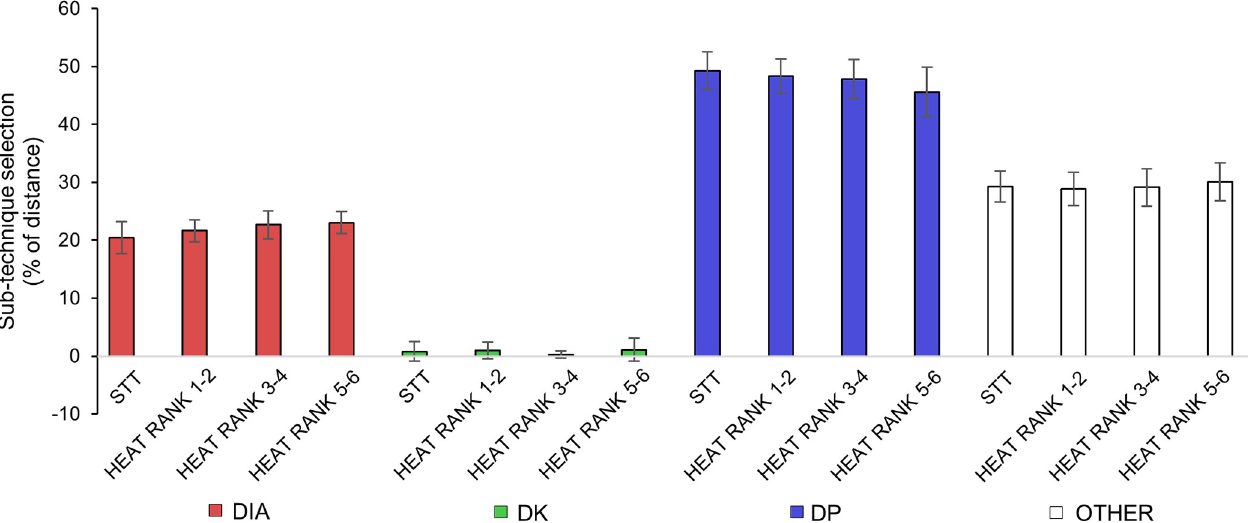
Fig 5. Sub-technique selection in relation to distance. The percentage use of sub-techniques (diagonal stride [DIA], double poling with a kick [DK], double poling [DP]) and ([Other] including tuck and turning techniques) in relation to distance across the racecourse during the sprint time-trial and heats of a classical sprint cross-country skiing race for elite male skiers. Error bars indicate SD [N =